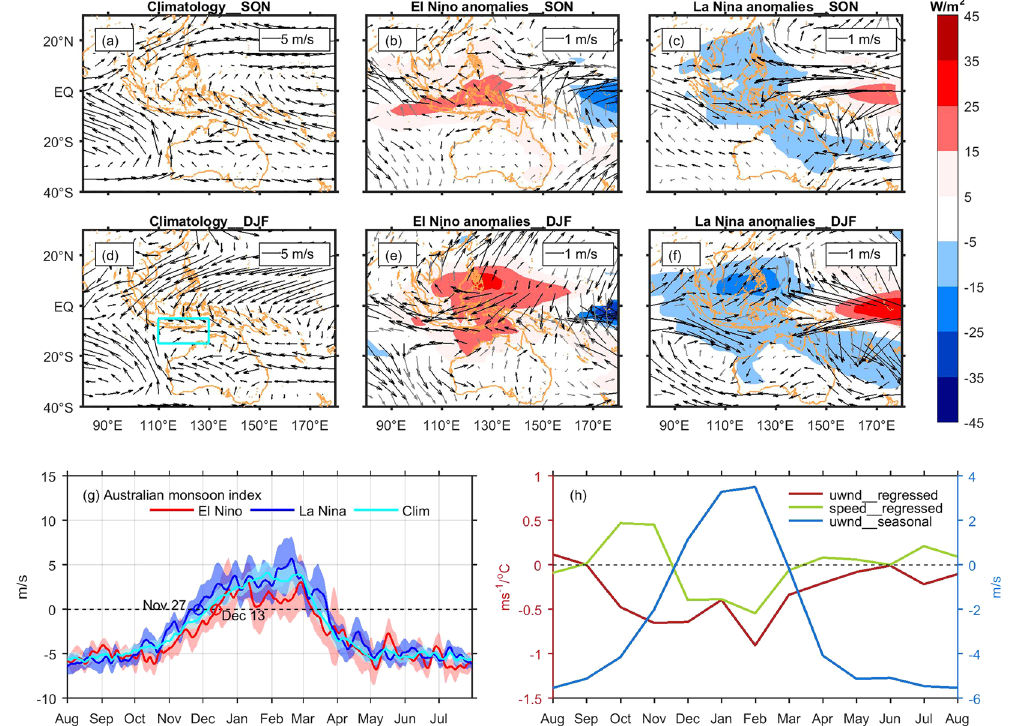
Figure 5. ( a – f ) Climatological mean, anomalous 925 hPa wind (arrows) and OLR anomalies (shaded) during spring and summer of opposite ENSO polarities. Anomalies exceeding the 90% significant level based on a two- tailed Student’s t test are displayed (black arrows for significant wind anomalies and grey for insignificant ones). The cyan box in ( d ) indicates the region where the Australian monsoon index is defined. ( g ) The composites of the Australian monsoon wind index. The red and blue circles are onset dates of Australian summer monsoon during El Niño and La Niña respectively. The shadows denote corresponding 95% confidence intervals. ( h ) Lagged regression of 850 hPa zonal component of wind and wind speed averaged in the box indicated in ( g ) onto Niño3 index in January and seasonal cycle of 850 hPa zonal component of wind averaged in the box. Figures are plotted using MATLAB R2015b (http://www.mathworks.com/). The maps in this figure are generated by MATLAB R2015b with M_Map (a mapping package,